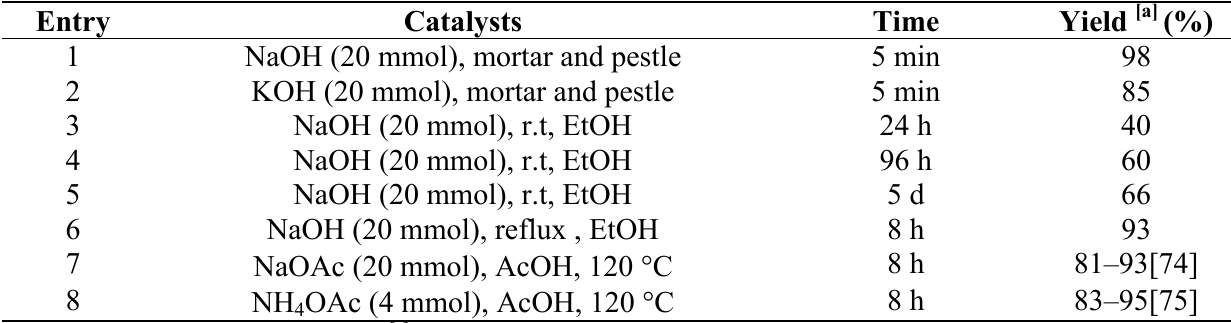
Table 2. Effect of the catalysts, solvents, temperature on the Claisen-Schmidt reactions of 1b with 2a .